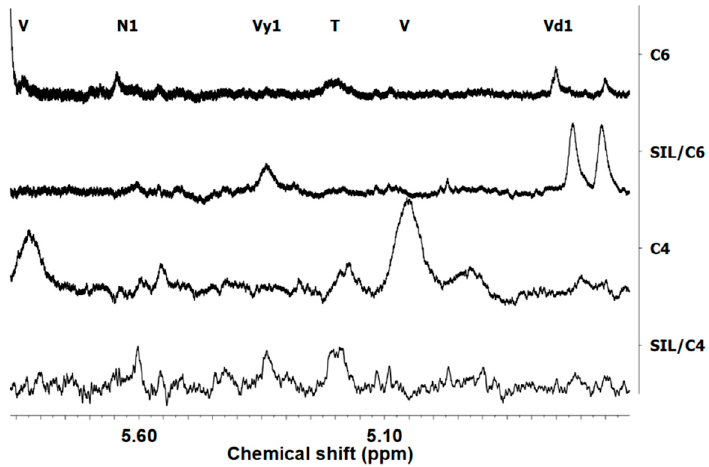
Figure 4. 1 H NMR spectra of E-NB copolymers obtained using homogeneous ( C6 , C4 ) and heterogeneous ( SIL / C6 , SIL / C4 ) catalyst with the highest NB incorporation degree (Table 1, item 27, 24, 12, 15).